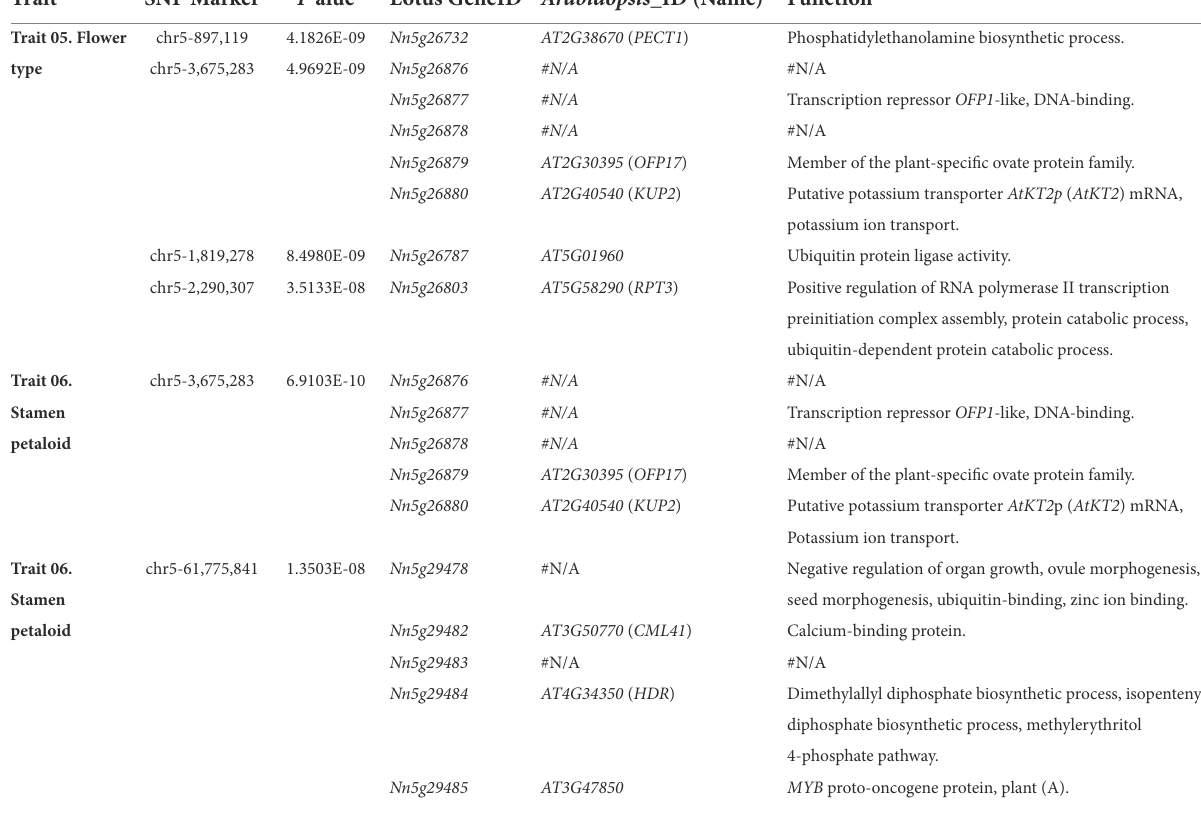
TABLE 1 The number of candidate coding genes significantly associated with flower types and stamen petaloid in 88 lotus accessions.